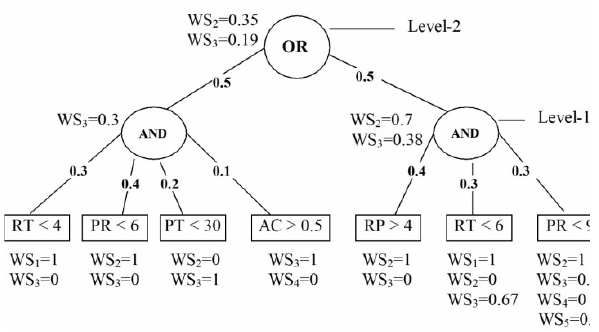
Figure 6. Example of the